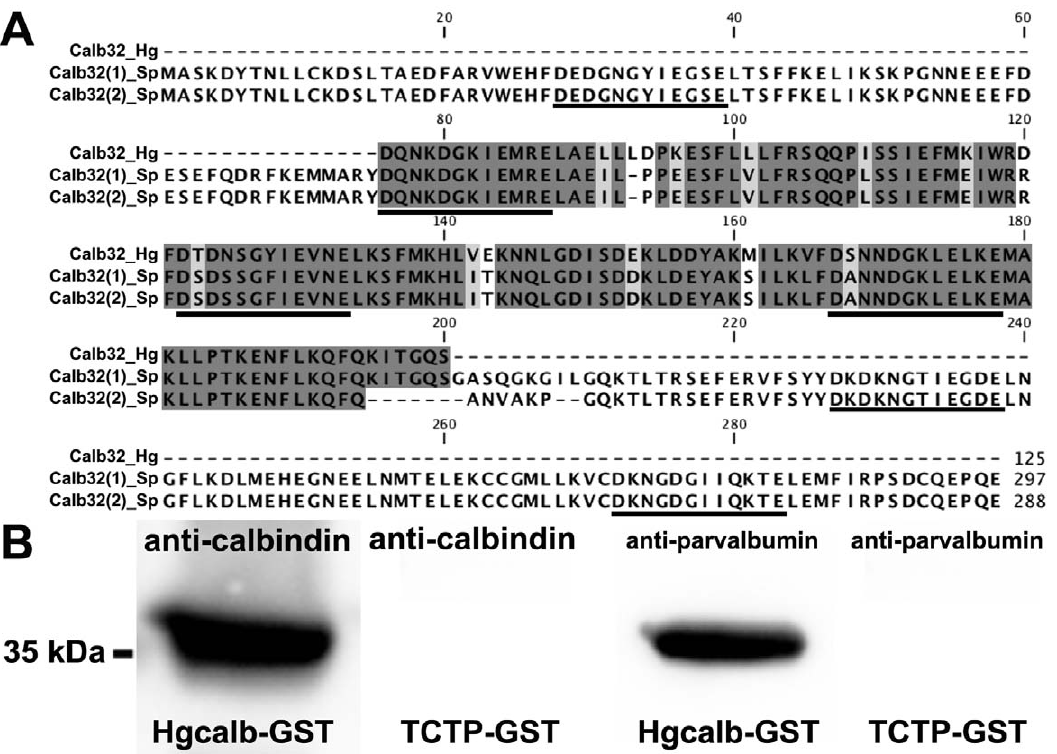
Figure 8. Identification of calbindin-D32k as the anti-calbindin 1 and anti-parvalbumin epitope in echinoderms. (A) Sequence alignment of H. glaberrima calbindin-D32k fragment (Calb32_Hg) and S. purpuratus calbindin-D32k isoform 1 (Calb32(1)_Sp) and isoform 2 (Calb32(2)_Sp), showing a high degree of homology. Alignment of the proteins was made using the CLUSTALW multiple sequences alignment. Dark gray represent conserved residues, light gray represent conservation of strong groups, and black lines below the residues represents the presence of an EF hand domain. (B) A 36 kDa immunoreactive band to anti-calbindin 1 and anti-parvalbumin was observed in the H. glaberrima GST-tagged calbindin-D32k fragment peptide (Calb32_Hg), and no immunoreactive band to anti-calbindin 1 and anti-parvalbumin was observed in the negative control, GST-tagged translationally controlled tumor protein (TCTP).